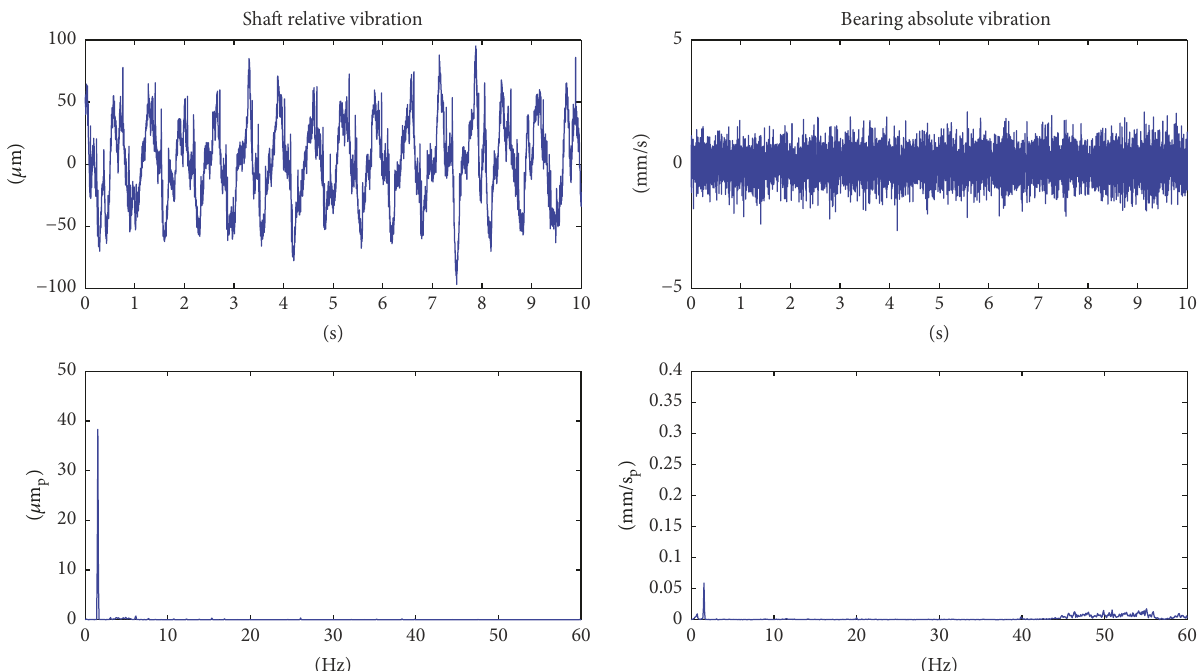
Figure 16: Measured shaft relative and bearing absolute vibrations at 𝑋 direction of the lower journal bearing, when generator rotor had an unbalance